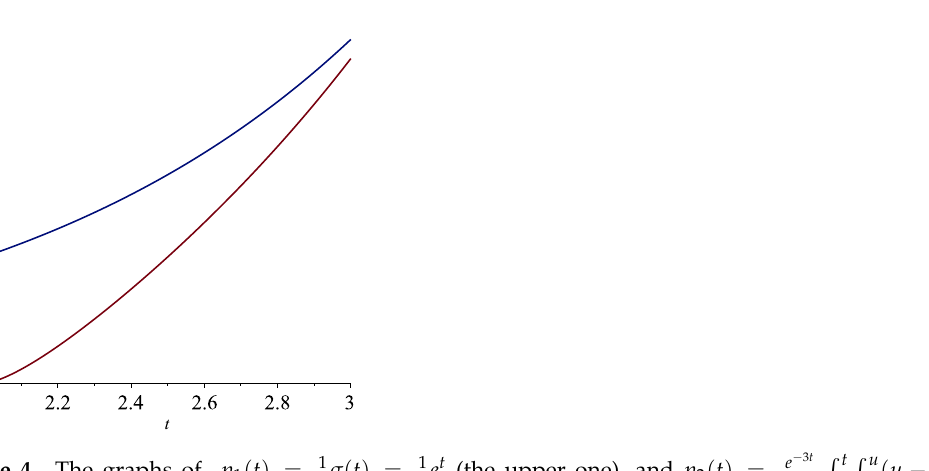
Figure 4. The graphs of p 1 ( t ) = 1 s ) 3 2 − 2 e 3 u σ ( s ) d s d u , t ∈ [ 2,3 ] . Take y ( t ) = 1 (cf. Figure. 5)